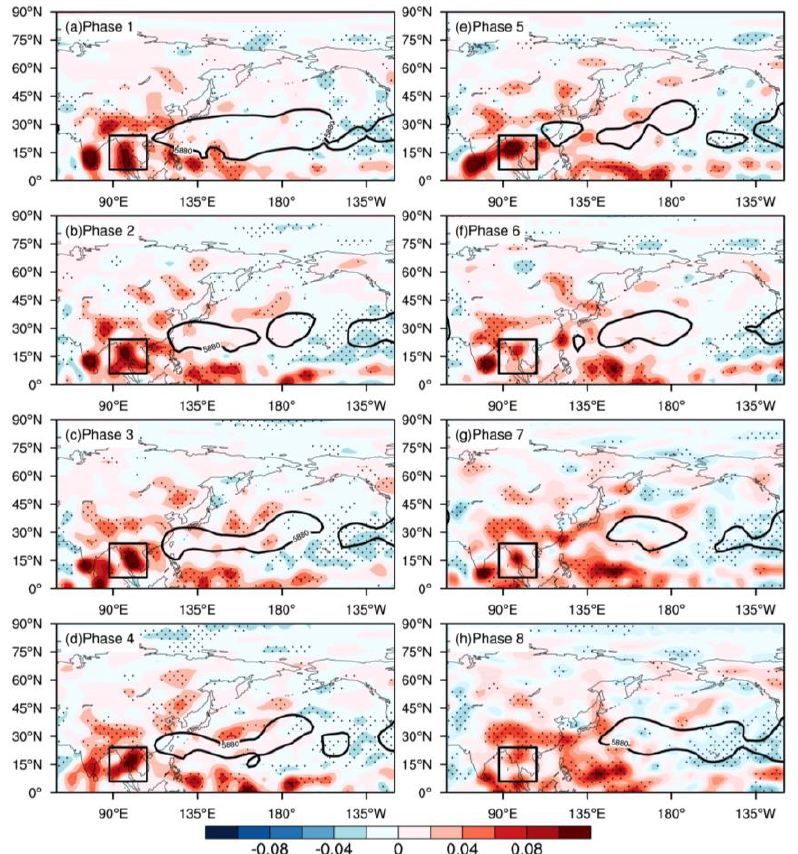
Figure 6. Temporal evolution of ( a – h ) 500 hPa original apparent heat source Q 1 field (shading; units: W/kg). The area shown in the black box is (6° – 24° N, 88° – 108° E), black contours in the panel are 500 hPa geopotential height by 5880 gpm that represent the WPSH location. Black dots represent values exceeding the 90% confidence level.